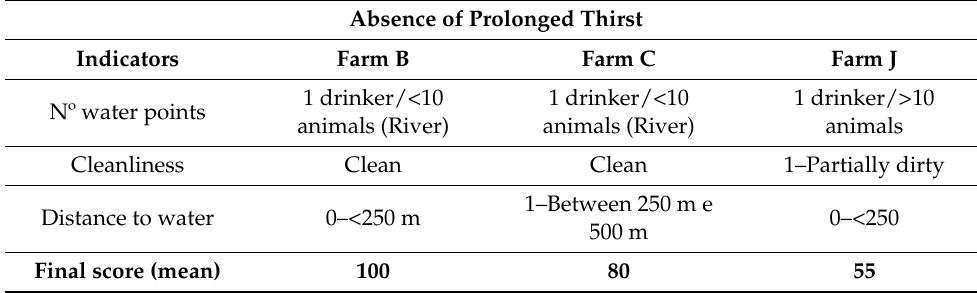
Table 10. Results from the assessment of water availability and